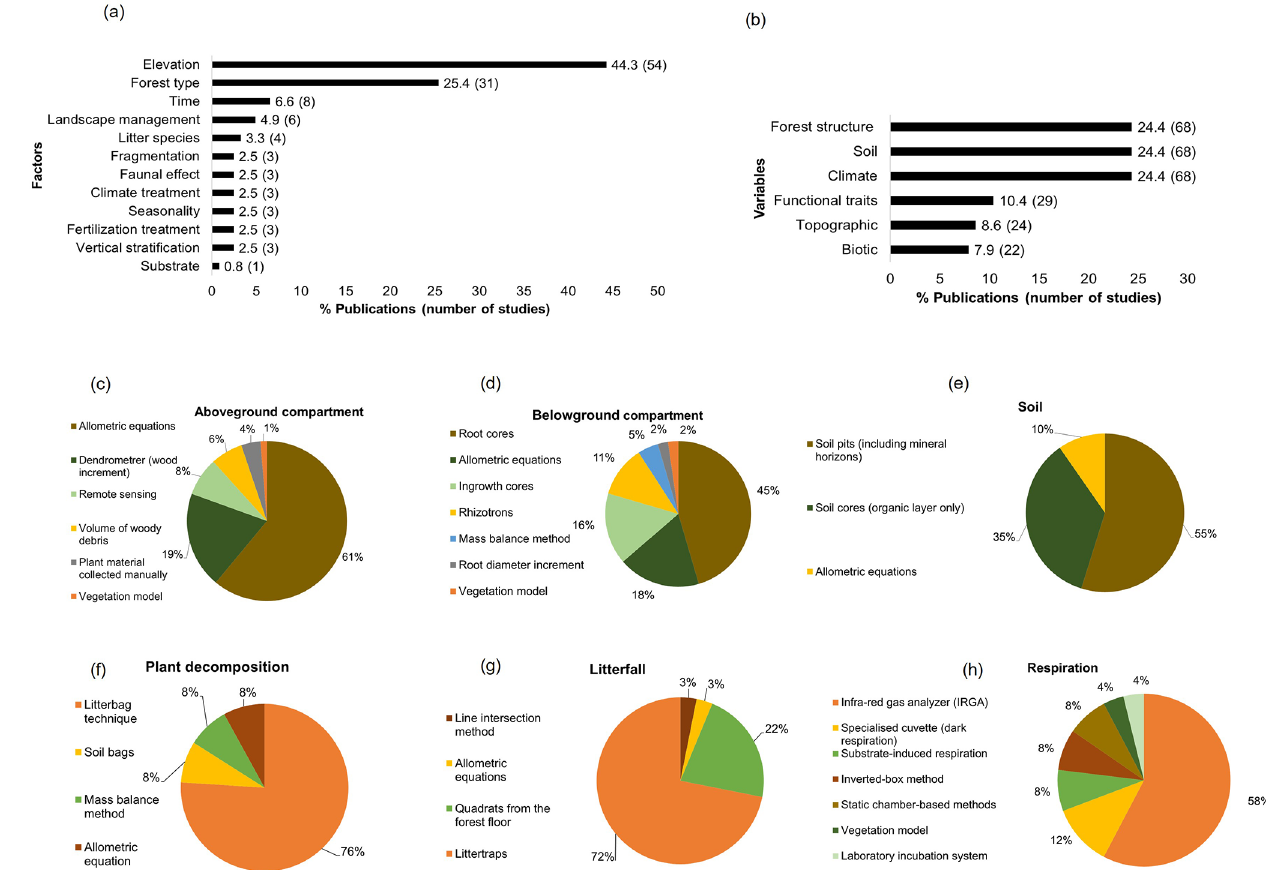
Figure 4. Methodology employed in the studies of the carbon cycle in tropical upland ecosystems. (a) Factors analysed in the studies, (b) complementary variables evaluated in the studies of the carbon cycle, (c) methods employed to quantify carbon in the aboveground com- partment, (d) belowground compartment, (e) and soil organic matter. Methods used to estimate fluxes of (f) plant decomposition, (g) litterfall, and (h)